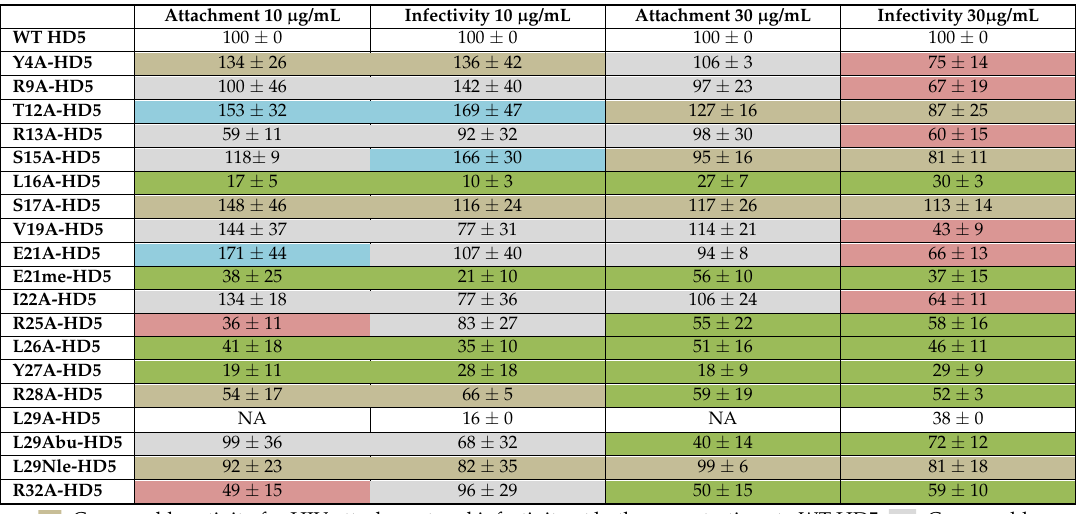
R28A-HD5 54 ± 17 66 ± 5